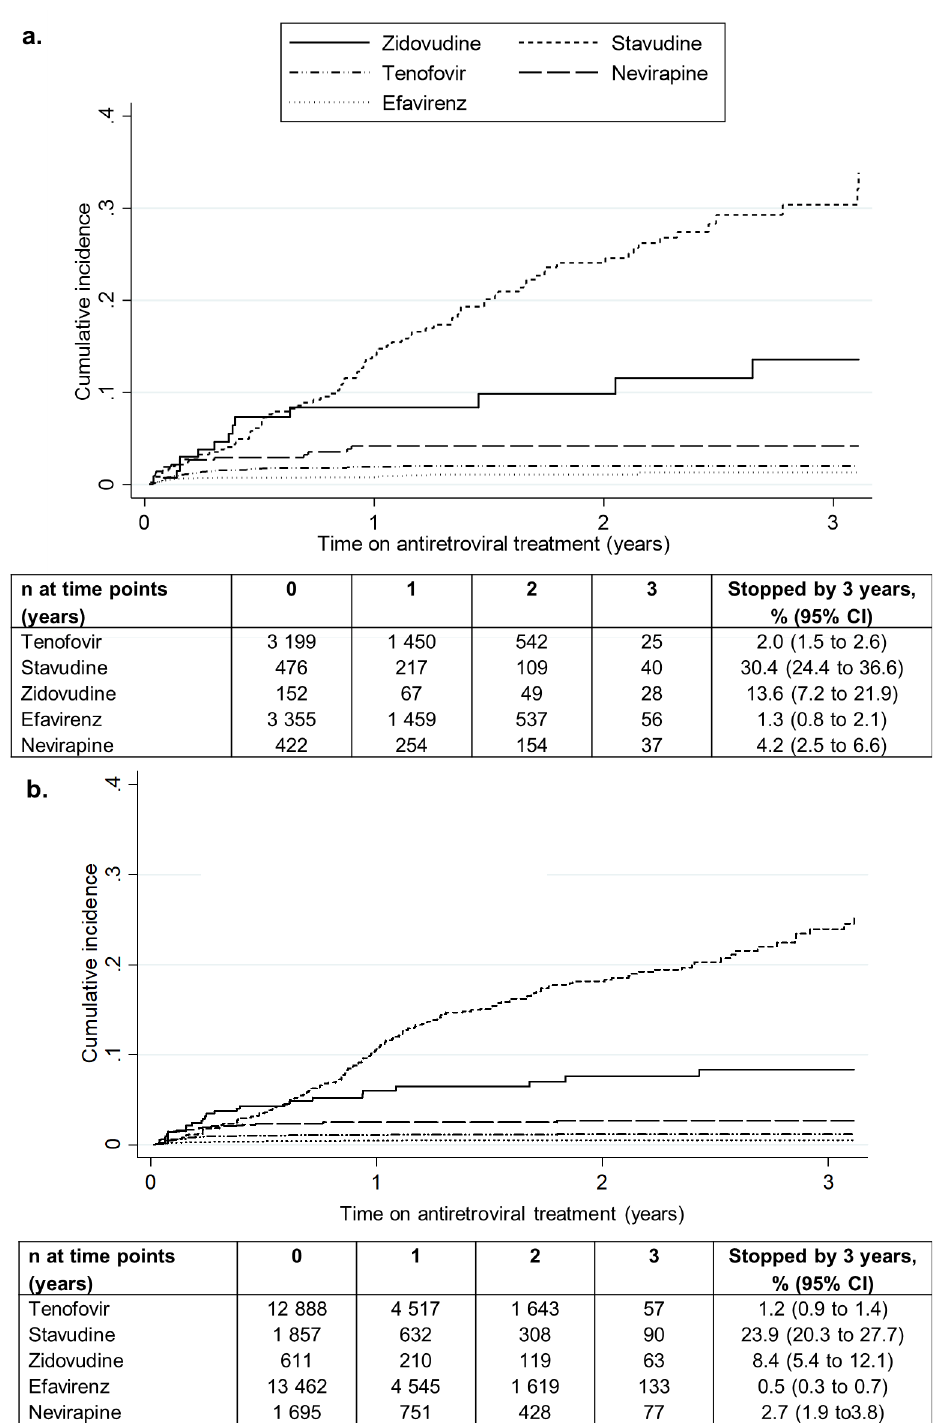
Fig 2. Cumulative incidence of antiretroviral discontinuations due to ADRs according to antiretroviral amongst a. enhanced-data sample patients (n = 3 837) and b. routine-data patients (n = 11 559) from two South African cohorts, who initiated antiretroviral treatment from